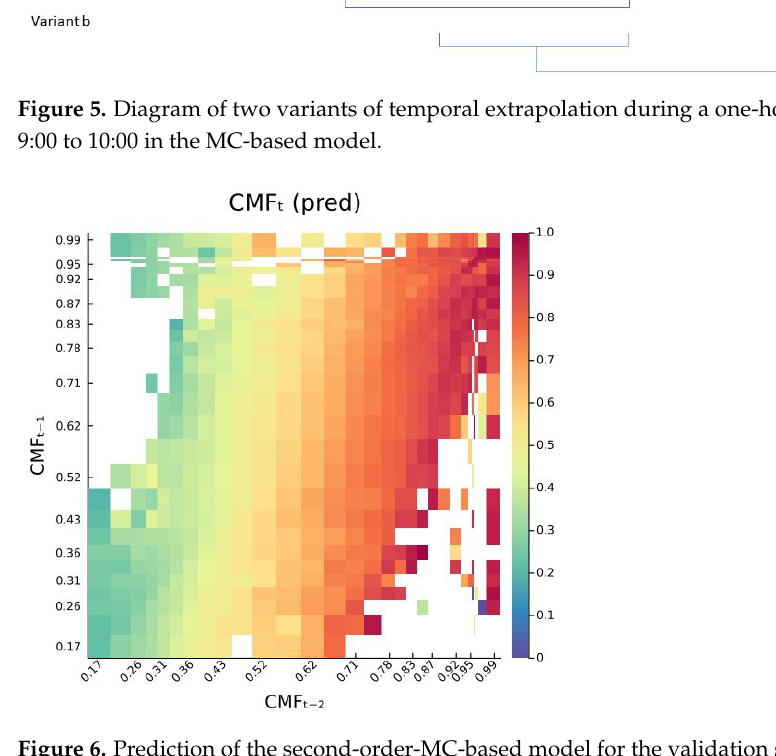
Figure 6. Prediction of the second-order-MC-based model for the validation set (2019) in